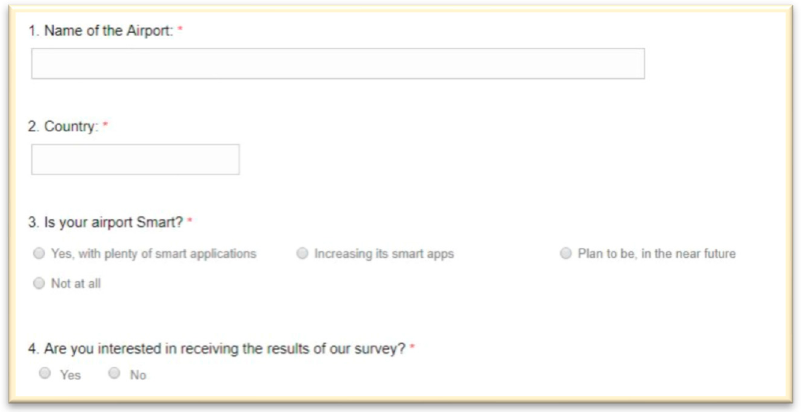
Figure A1. Questions about the airport's details.